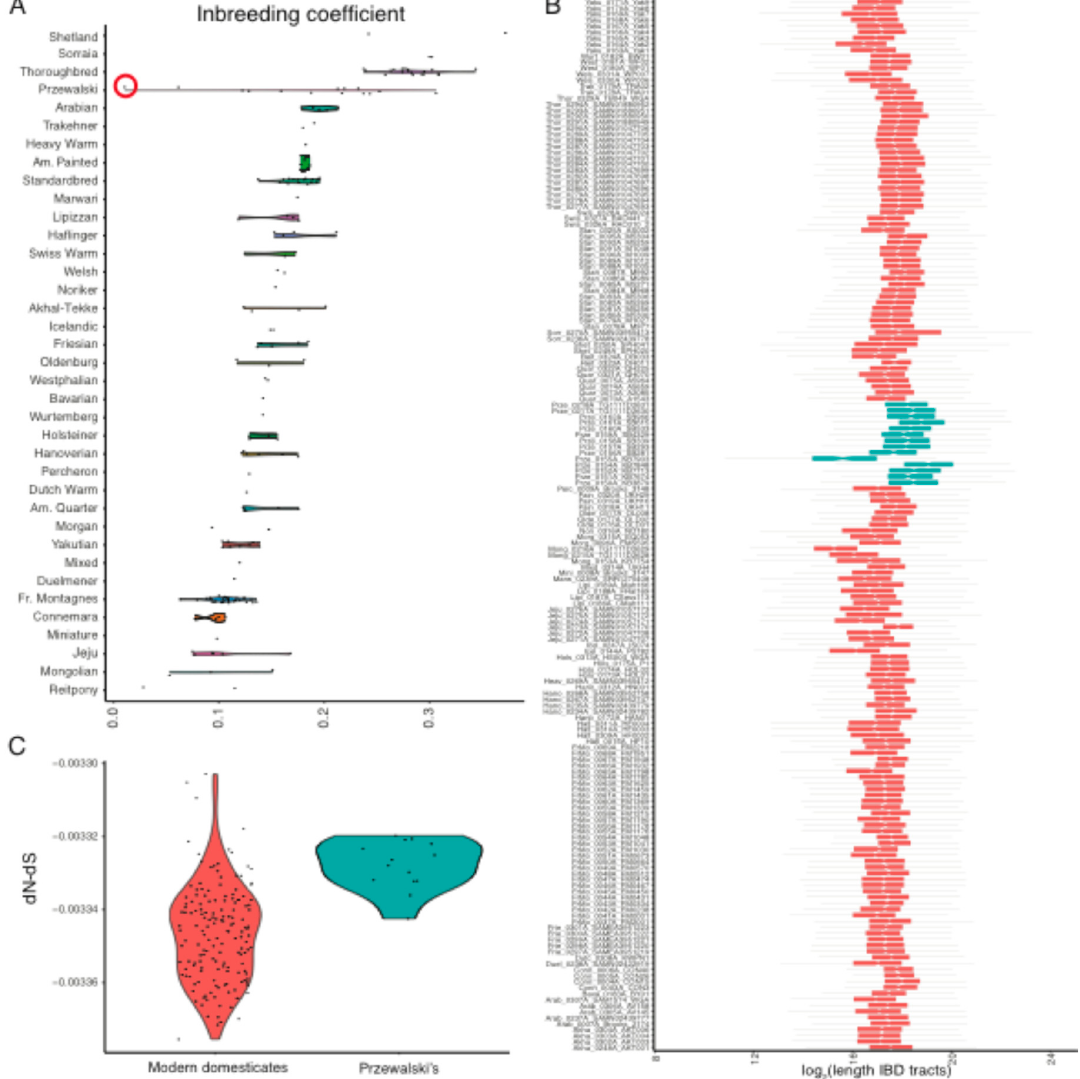
Figure 4. Inbreeding depression and genetic purging: ( a ) Inbreeding per breed; ( b ) Box plot summarizing the length of ROHs in a given individual horse. The ROH length is represented in log 2 scale to avoid excessive distortion caused by outliers. In this scale, a value of 18 corresponds to 2 18 = 262 Kb, while a value of 24 corresponds to 2 24 = 16 Mb; ( c ) Non-synonymous (dN) ˗ synonymous (dS) substitution rates, for Przewalski horses and modern domesticates. More negative dN ˗ dS values reflect more efficient selection. The specimen highlighted with a red circle corresponds to sample KB7903 in Der Sarkissian et al. 2015, and represents an F1 hybrid between a Przewalski horse and a domestic horse.